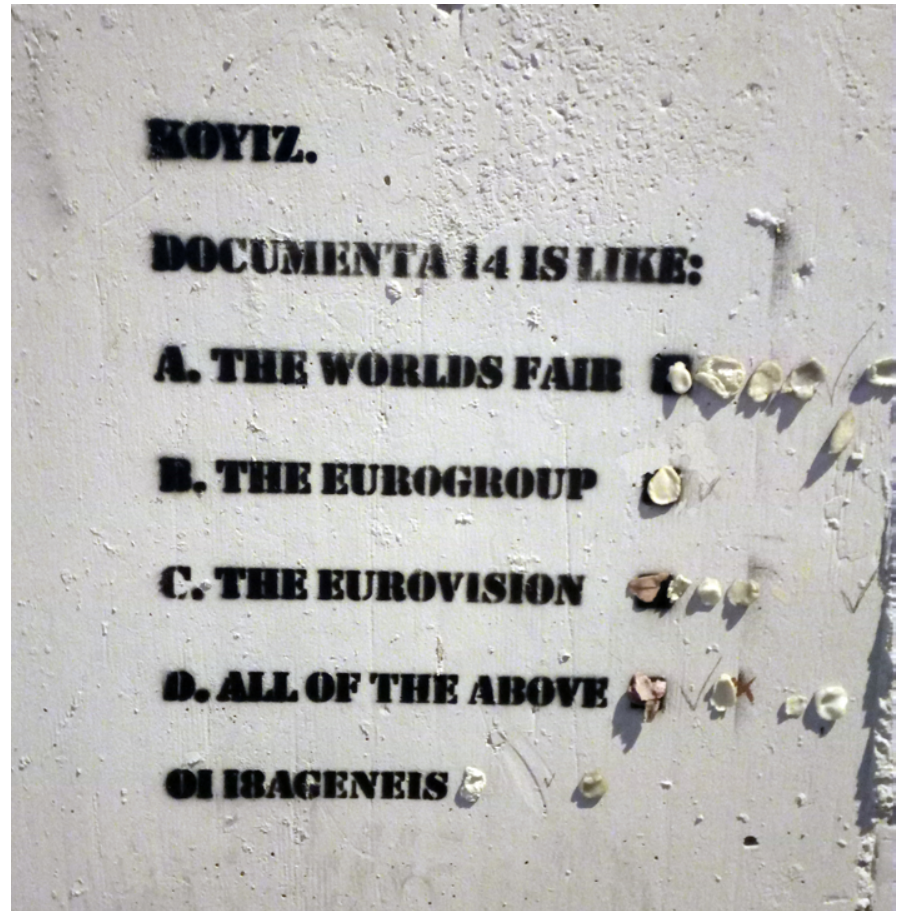
“Stensil at Kallirois str. in Athens.” Photo by Styliani Bolonaki (February